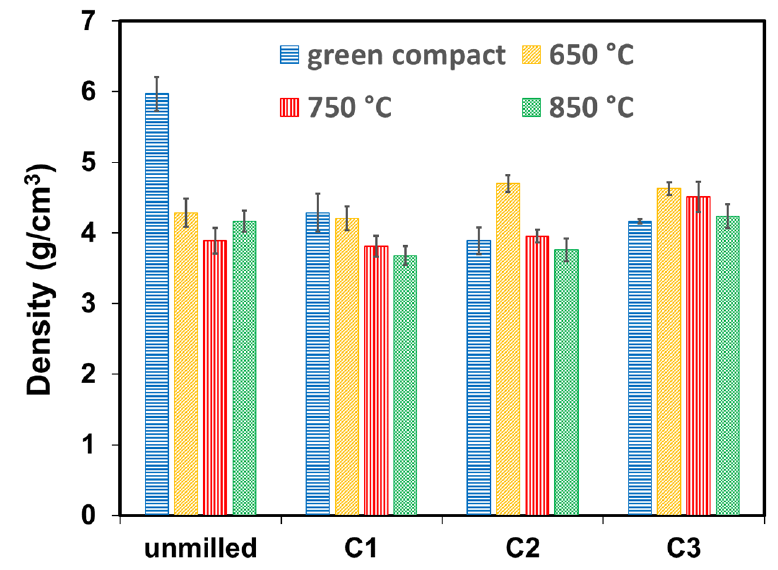
Figure 9. The density of green and sintered samples were prepared from powders with different milling times.